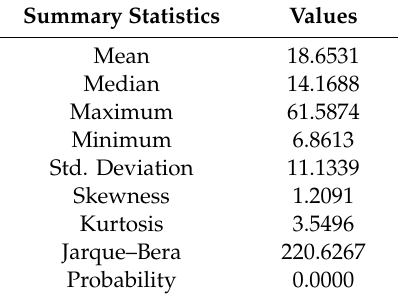
Table 1. Descriptive Statistics.